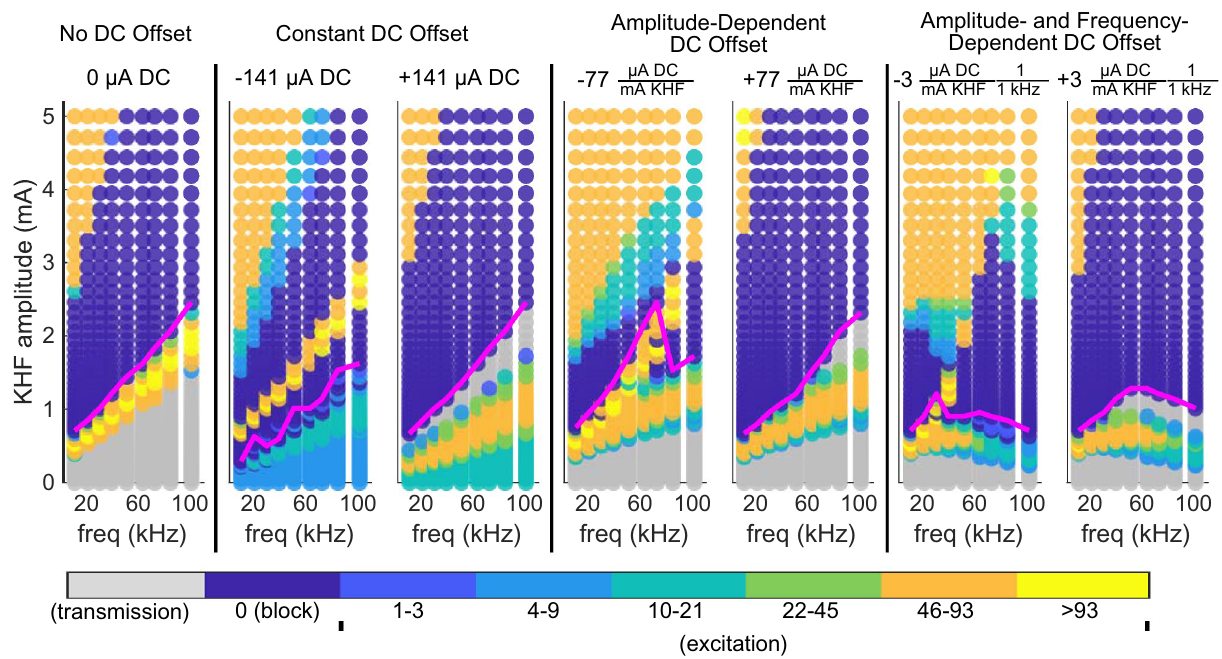
Figure 8. Representative examples of KHF amplitude and frequency effects on transmission, excitation, and block across a range of DC offset types for symmetric KHF waveforms from 10 to 100 kHz in computational models of 5.7 μm diameter myelinated fibers. Heatmaps show the number of action potentials that occurred between t = 100 and 250 ms at all KHF amplitudes, frequencies, and polarities across a representative subset of DC offset levels from Fig. 3. Action potential counts were binned and color-coded (colorbar). The type, amount, and polarity of DC offsets are labeled above each plot. The signs of the DC offsets denote the polarity delivered to the proximal contact (Fig. 2). DC offset types are labeled above each group of plots. KHF amplitudes were sampled from 0.05 to 5 mA in 6% increments. Gray transmission dots indicate the presence of exactly three action potentials spaced apart in time by 50 ms, corresponding to the number and timing of test pulses between 100 to 250 ms. KHF amplitude was half of the peak-to-peak KHF waveform amplitude. Magenta lines show block threshold curves from corresponding panels in Fig.